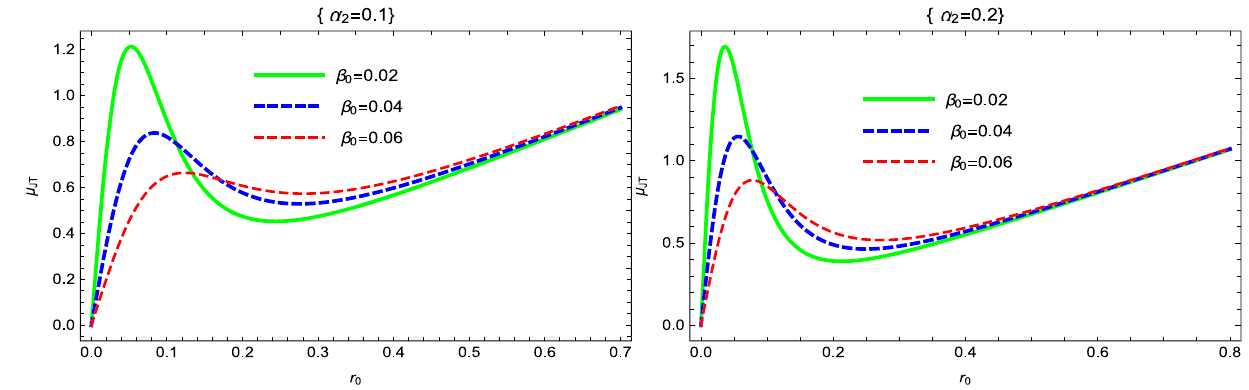
Fig. 10 Plot of Joule–Thomson Coefficient with fixed value of α 2 = 0 . 1 and β 0 = ( 0 . 02 , 0 . 04 , 0 . 06 ) {left} and α 2 = 0 . 2 and β 0 = ( 0 . 02 , 0 . 04 , 0 . 06 ) {right}